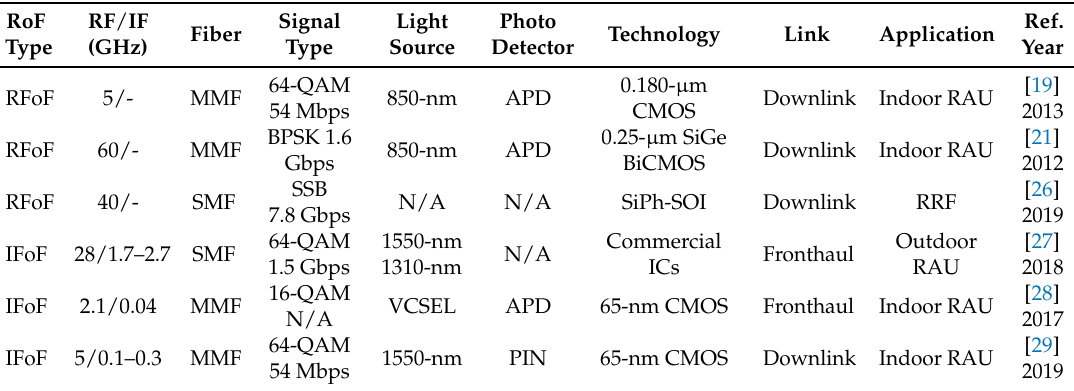
Table 1. A summary for RFoF and IFoF architectures reviewed in this